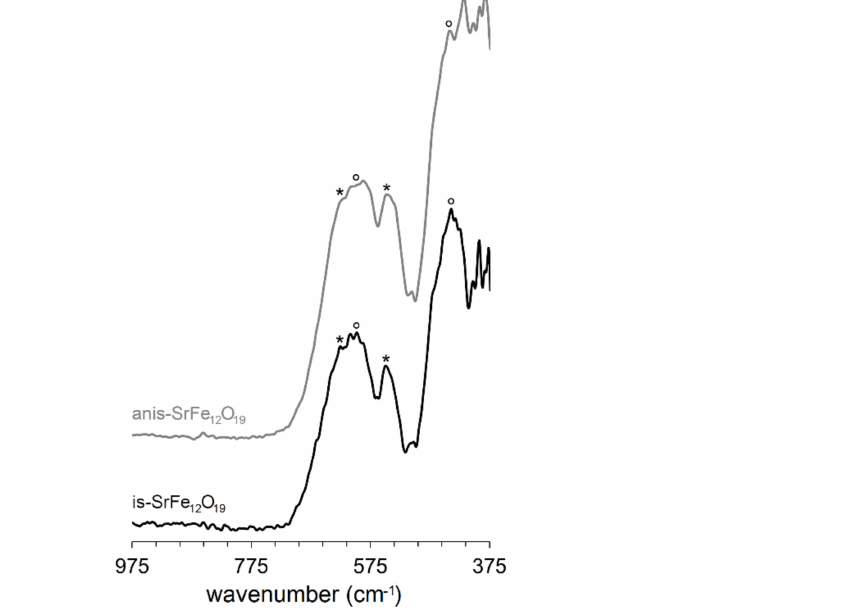
Figure 2. FTIR spectra of is-SrFe 12 O 19 and anis-SrFe 12 O 19 in the range 975–375 cm − 1